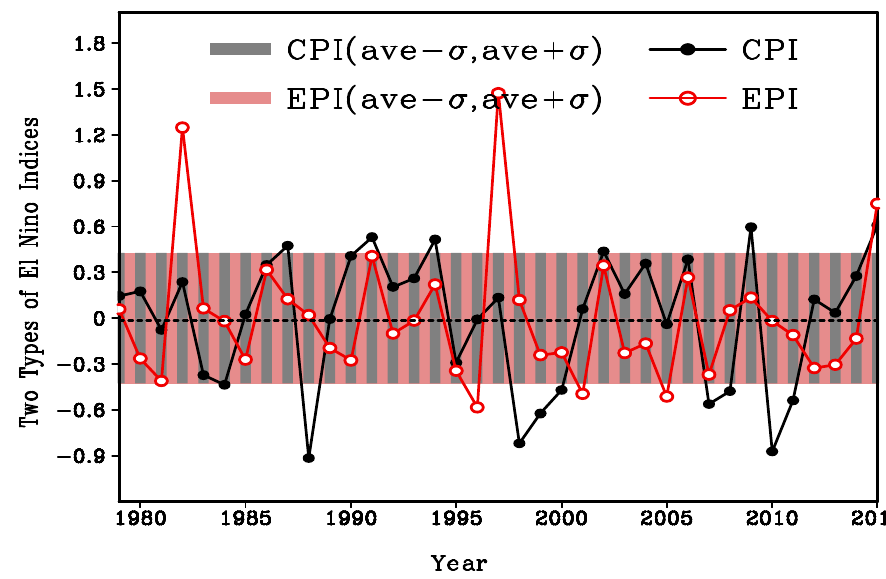
Figure 1. Time series of the two types of El Niño indices (the shaded areas are the standard deviation of the two indices; the CPI (Central Pacific ENSO index) standard deviation is 0.427, and the EPI (Eastern Pacific ENSO index) standard deviation is 0.429).